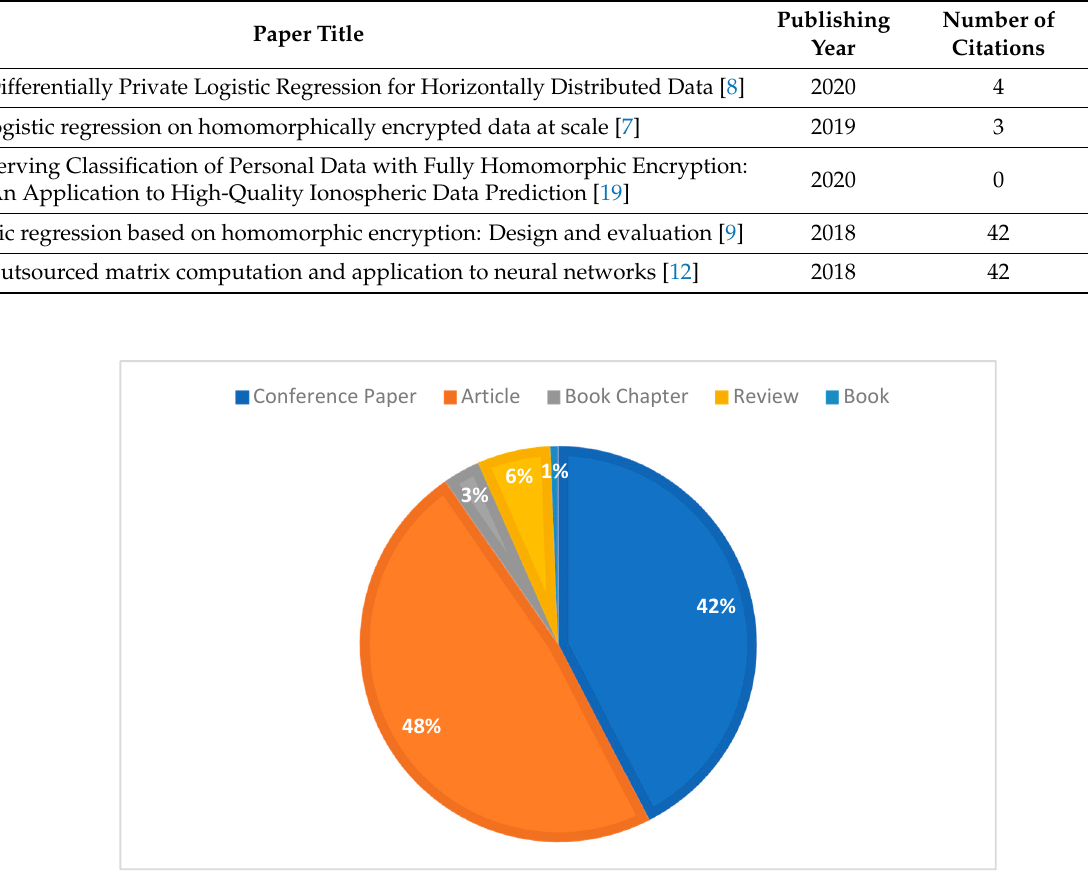
Figure 11. Proportion of types of literature data sets related to [5].